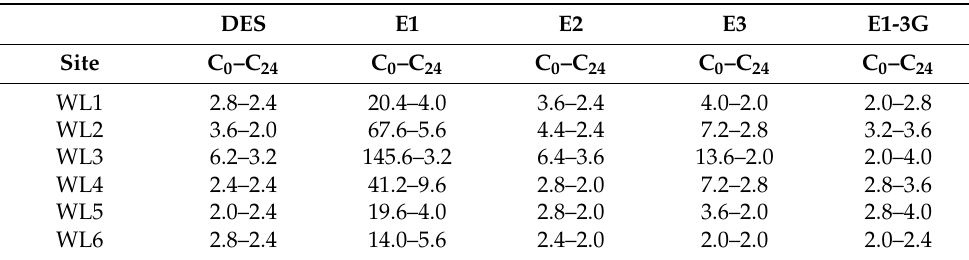
Table 3. Initial estrogen concentrations (C 0 ) and concentrations at 24 h (C 24 ) of target estrogens for water sample (ng/L).